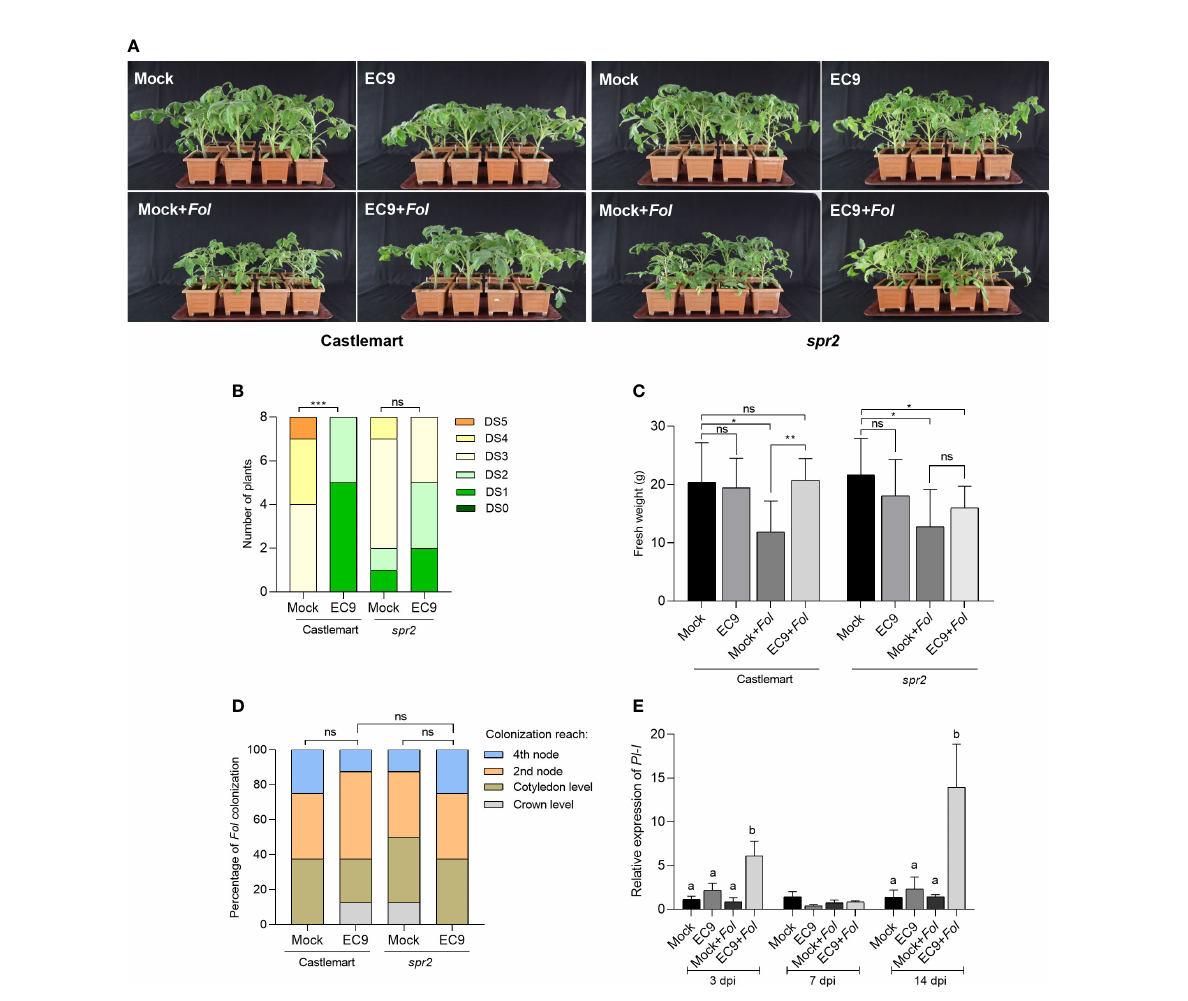
FIGURE 3 EC9-mediated enhanced defense against Fol involves JA signaling pathway. (A) Disease symptoms, (B) disease severity score, and (C) fresh weight of Spr2 mutant and the corresponding wild type cv. Castlemart at 21 days post-inoculation (dpi) (n=8). Ten-days old tomato seedlings were treated with EC9 or 10 mM MgCl 2 (mock) by soil drenching and inoculated with Fol 1 week after treatment. (D) Percentage of Fol infected stem sections at 21 dpi (n=8). ns non-signi fi cant, * P < 0.05, ** P < 0.01, *** P < 0.001,. The accumulation of transcripts of (E) proteinase inhibitor I ( PI-I ) in tomato plants (cv. Moneymaker) treated with EC9 or mock and inoculated with Fol was revealed by qRT-PCR (n=3). For gene expression analysis, stem pieces from the region between cotyledons and crown were harvested. The values were normalized to the internal reference transcript a -tubulin. Bars represent the means of the indicated number of biological replicates ± standard error. The experiments were repeated at least two times with similar results. Different letters indicate statistically signi fi cant differences between